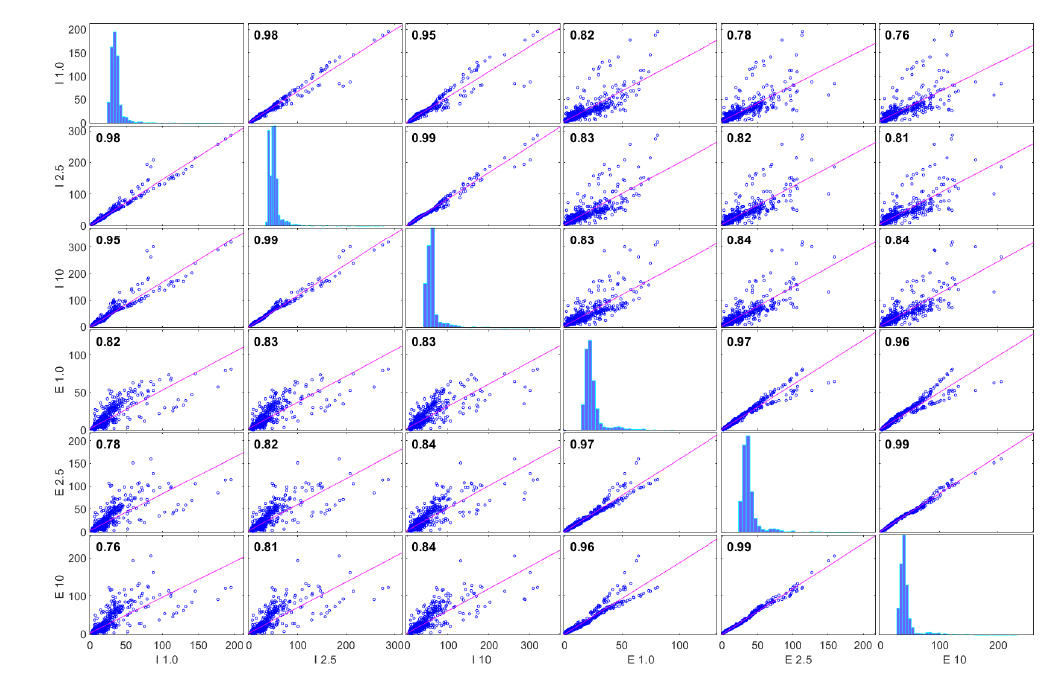
Figure 11. Histogram and correlation of measured PM concentrations with the source of pollution during